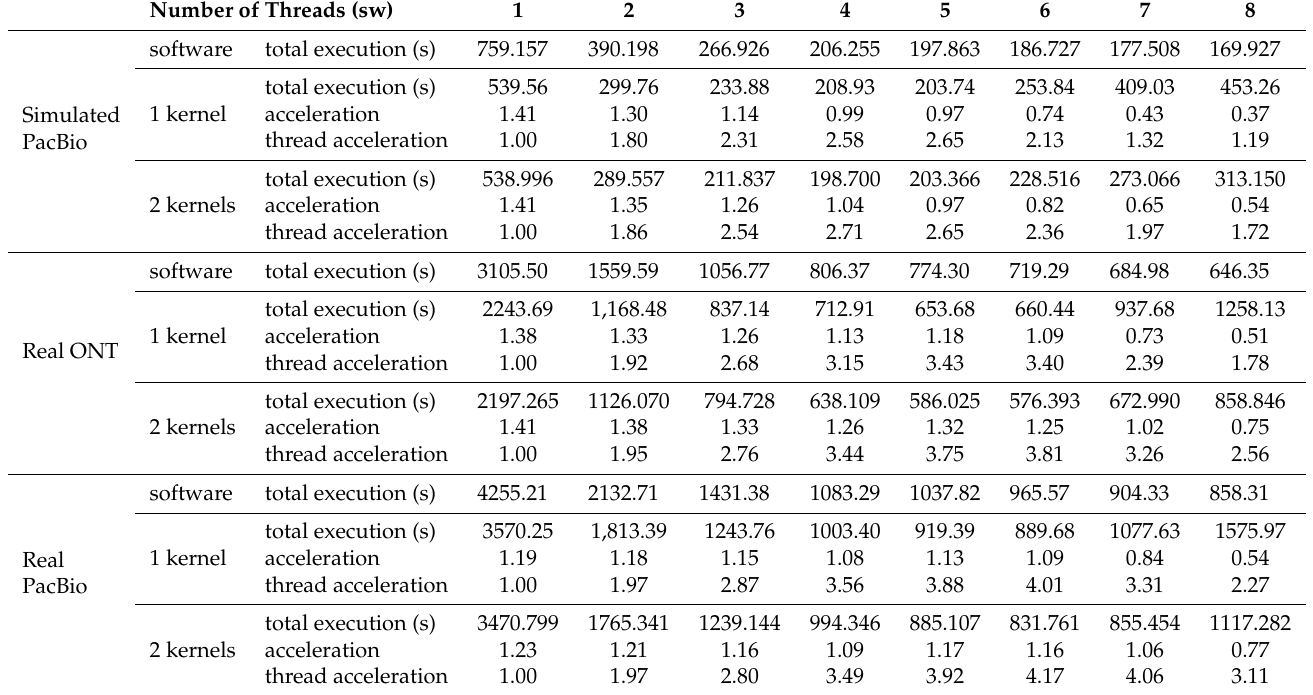
Table 6. Execution times and acceleration in the Minimap2-GACT-X integrated